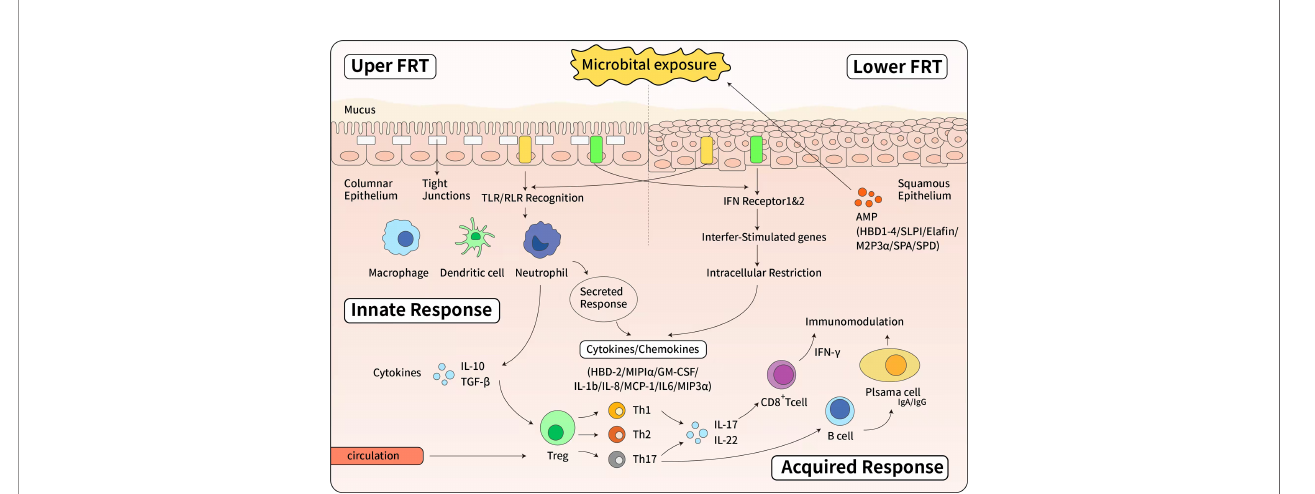
FIGURE 1 | The immune response offemalereproductive tract. Upside: The innate immune response ofupper femalereproductive tract. The upper femalereproductive tract, consisting ofthe Fallopian tubes, uterine endometrium and endocervix islinedby a singlelayer ofcolumnar epithelial cellslinked bytight junctions. The lower female reproductive tract, consistingof the ectocervixand vagina, iscovered by a layer of strati fi ed squamous epithelialcells. Below the epithelial layer are innate and adaptive immune cells, as wellas some AMPs. When pathogen invades to the epithelialcells, epithelial cells express a panelofToll-like receptors(TLRs)and RIG-like receptors (RLRs) that can recognize andrespond to bacteria or viruses. The TypeI interferon (IFN) response is a potent defense system in femalereproductive tract cells. Additionally,in response to pathogens, antimicrobialsand cytokines/chemokines are secreted to confer broad spectrum protection. Below: The effectorofadaptive immune response. Pathogen speci fi c adaptive responses are driven by mucosalmacrophages, dendriticcells, and epithelial cells thatdirectly present antigensto T and B cells. Once activated bycytokine stimulation,T and B cellsproliferate anddifferentiate. The cell-mediatedresponse ischaracterized by theproduction of IFNand cytotoxic CD8+ T cells that cause apoptosisof infectedcells. IFNalso stimulates the expression ofintracellular antiviral genes that block viral replication. The humoral response ismediatedby B cells differentiation into plasma cells that secrete antibodies. Both IgG and IgA are produced inthe female reproductive tractand secretedinto the